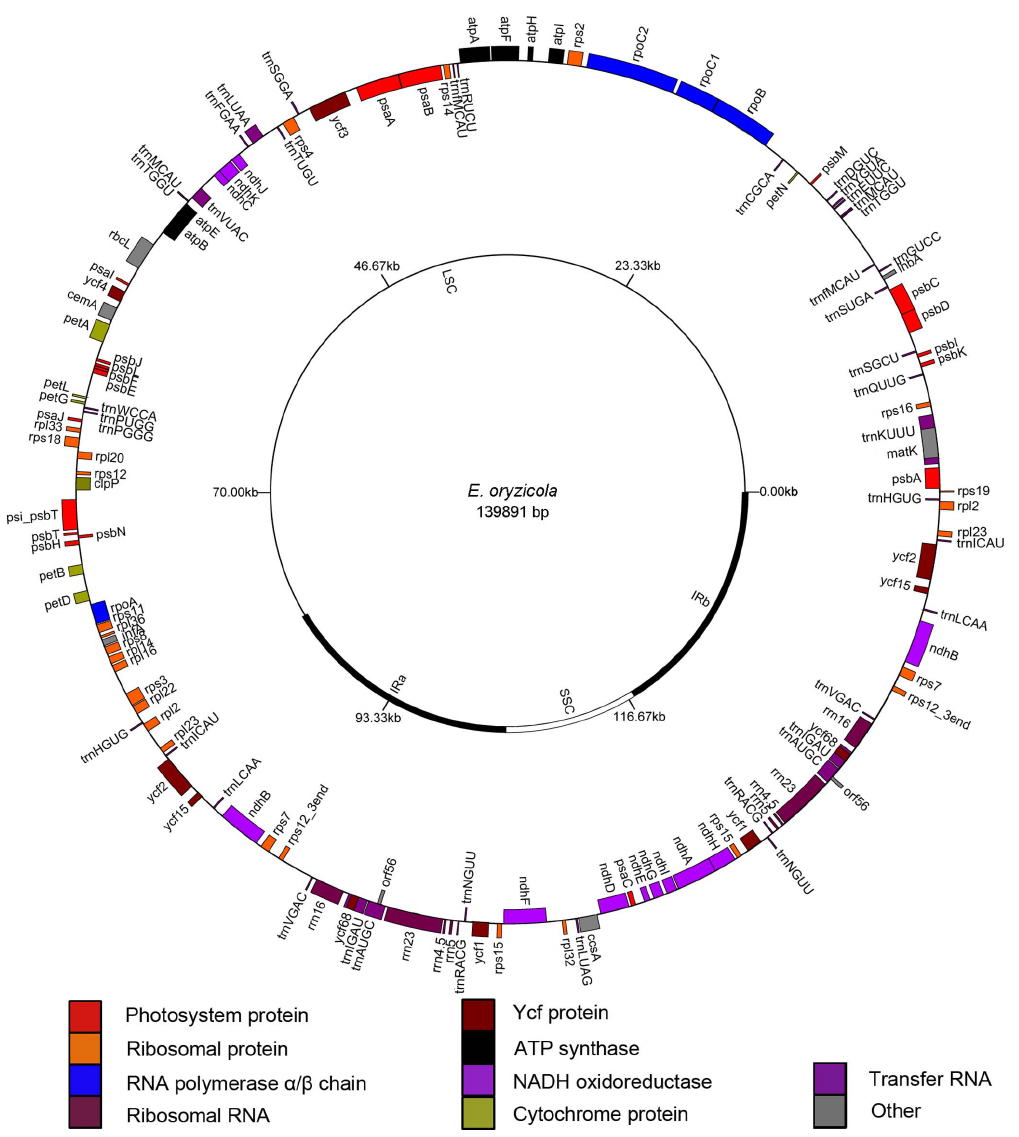
Figure 2. The E. oryzicola chloroplast genome structure and annotation. Outer circle: The genes shown outside of the circle are transcribed clockwise, whereas those inside are transcribed counterclockwise; Inner circle: the genomic structure with two inverted repeats (IR) and two single copy regions (LSC and SSC). Genes belonging to different functional groups are color